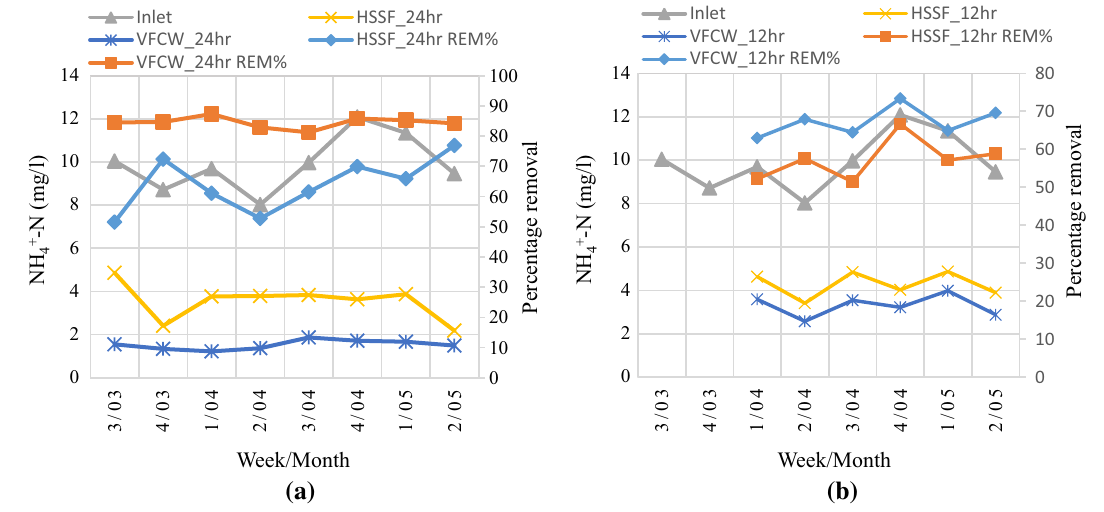
Fig. 6 a Ammonia nitrogen (NH4+N) influent, effluent concentration and percentage removal of HSSF-CW and VFCW for 24-h HRT, b ammo- nia nitrogen(NH4+–N) influent, effluent concentration and percentage removal of HSSF-CW and VFCW for 12-h HRT